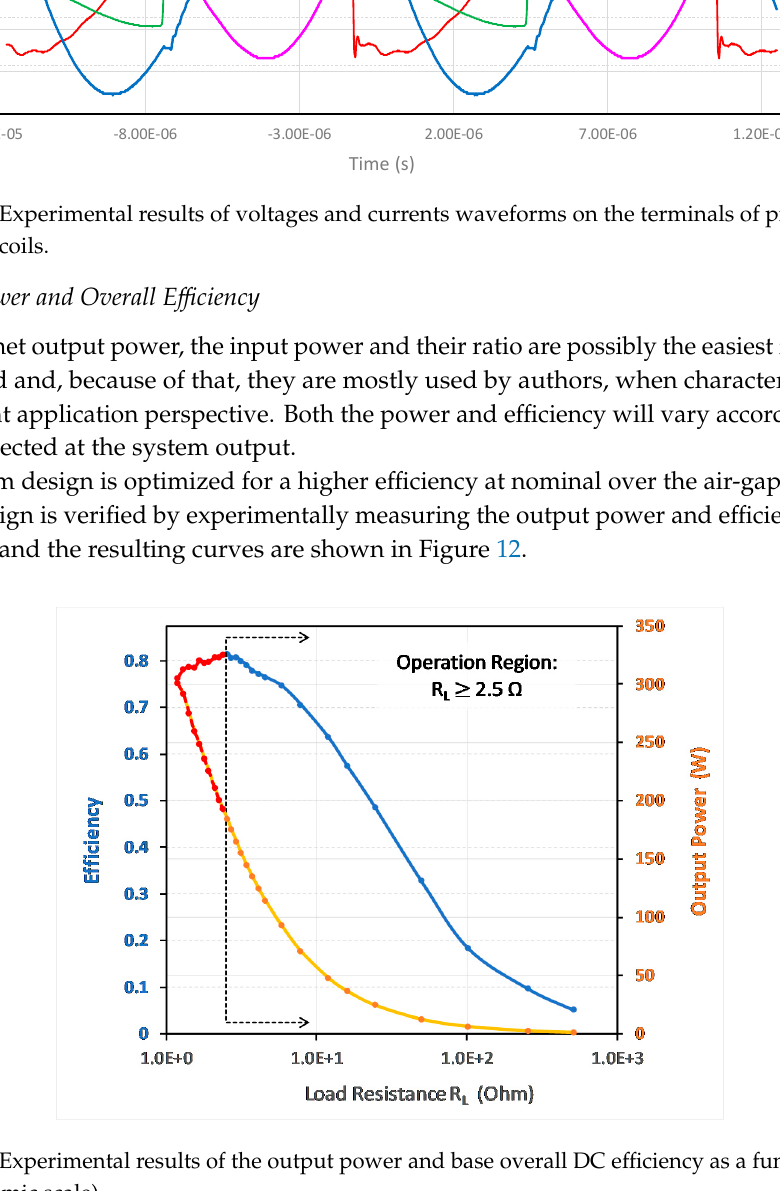
Figure 11. Experimental results of voltages and currents waveforms on the terminals of primary and secondary coils.